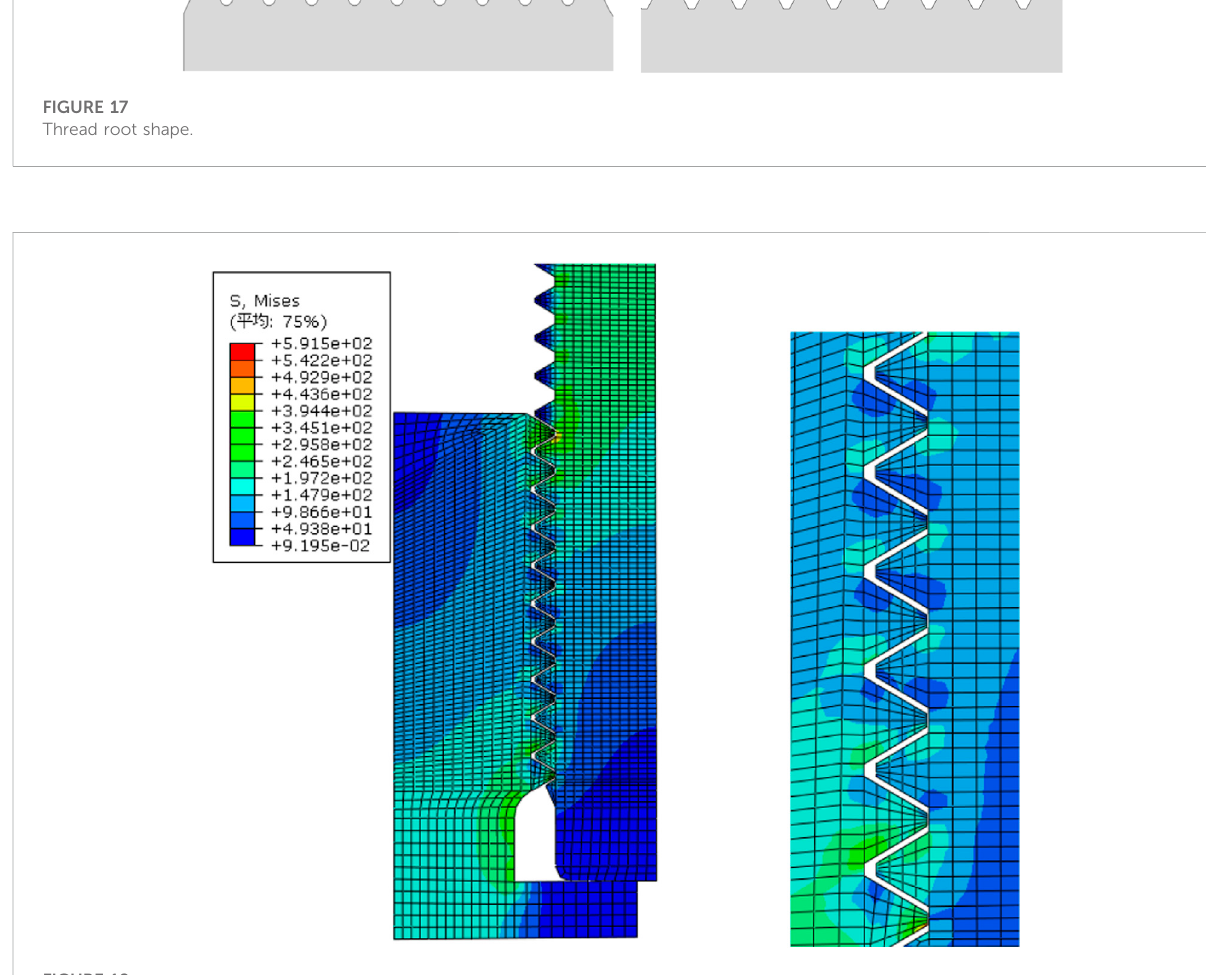
FIGURE 18 Trapezoidal stress cloud of the thread